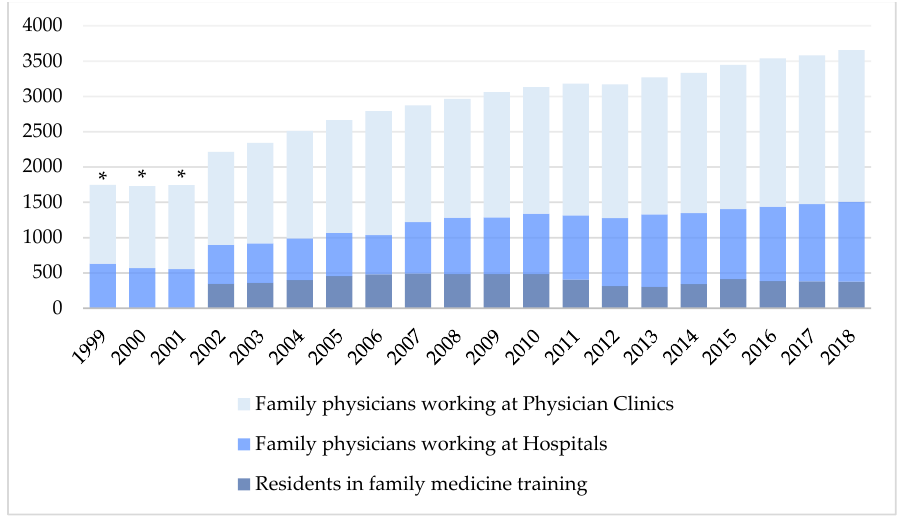
Figure 5. Changes in the numbers of residents in family physician training and number of family physicians in various practice settings in Taiwan from 2002 to 2018. *1999–2001 data of the number of residents in family medicine training are not available.